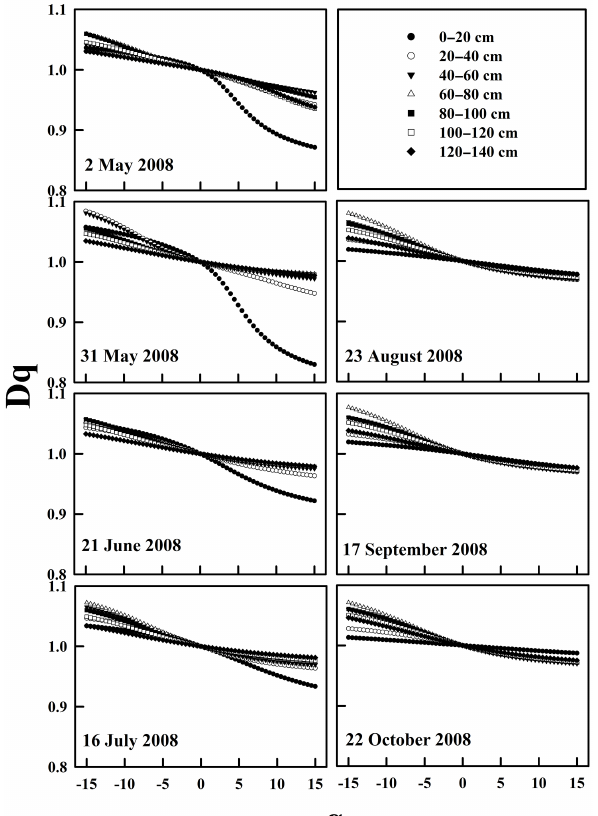
Figure 9. Generalized dimension spectra of soil water storage spa- tial series measured at each 20cm soil layer down to 140cm in 2008 for a range of q ( − 15 to 15 at 0.5